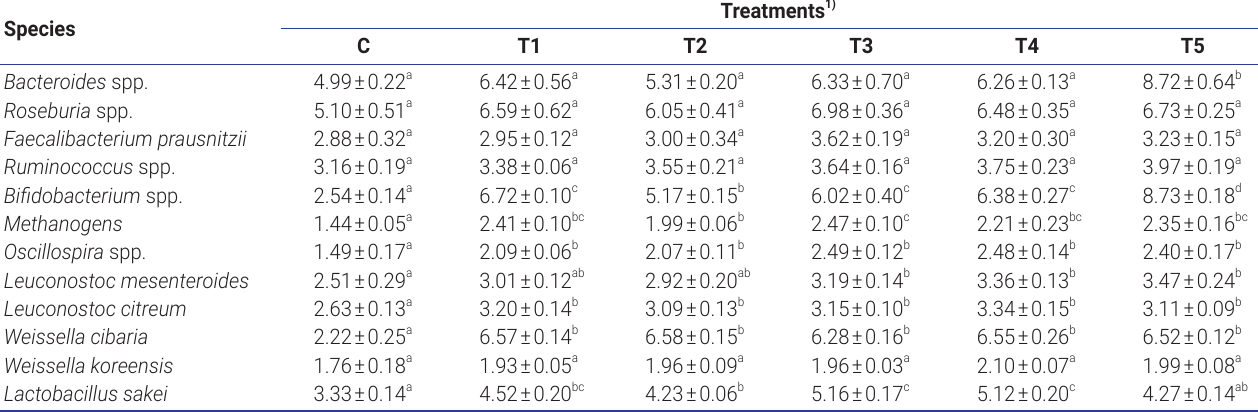
Table 3. Comparison of short-chain fatty acids-producing bacteria and LAB containing gut-dominant microorganisms by quantitative polymerase chain